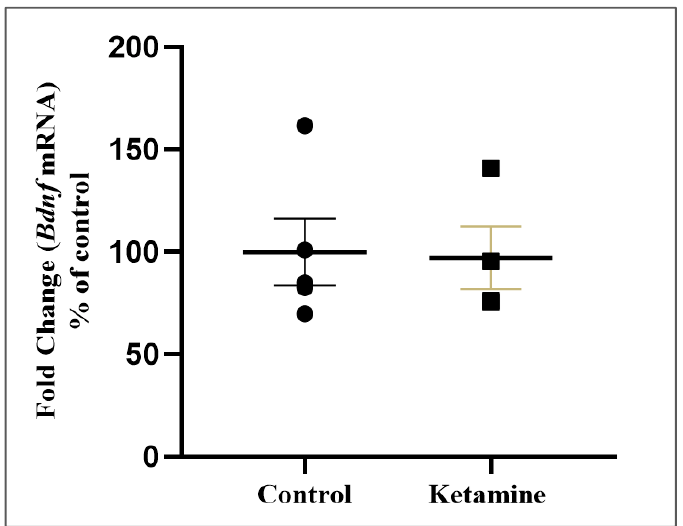
Figure 7. Effects of ketamine recreational regimen (10 mg/kg/day for 3 days, i.p) or saline (control group) in the early withdrawal stage (24 h) on hippocampal brain-derived neurotrophic factor (BDNF) levels of adolescent female Wistar rats ( n = 5 animals/group). Results were expressed as percentual of control group. Mann–Whitney